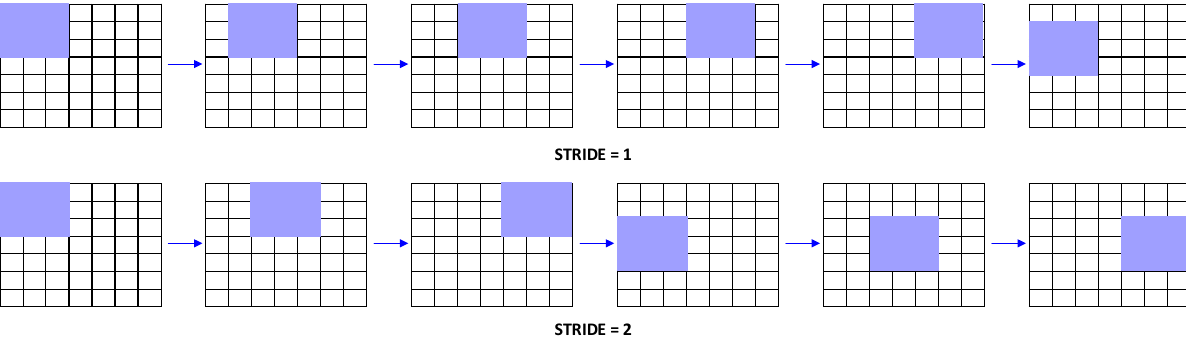
Figure 3. Strides example in AlexNet.